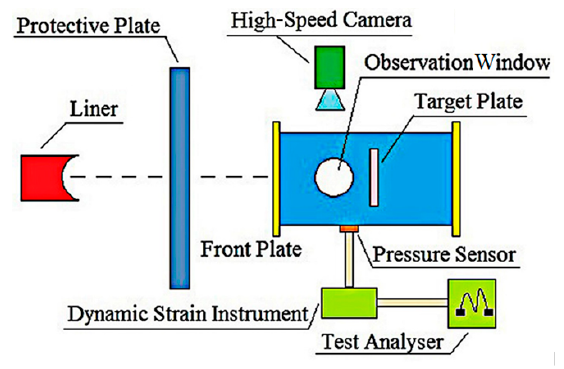
Figure 2. Schematic diagram of the energy acquisition system.